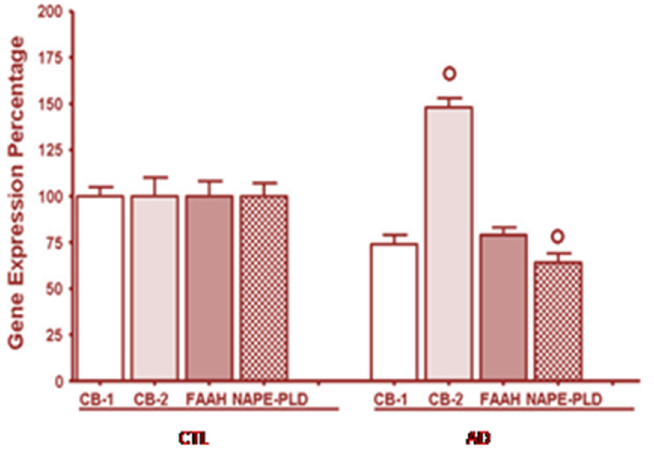
Figure 2. Over-expression of the CB2 receptor gene, but not of the cannabinoid receptor 1 (CB1) andfatty acid amide hydrolase (FAAH) enzyme, and down-expression ofthe NAPE-PLD gene in peripheral blood mononuclear cells of autistic children. CTL healthy control subjects, AD autistic patients. Reprinted from [7], with permission from Springer (license #5034221089815).